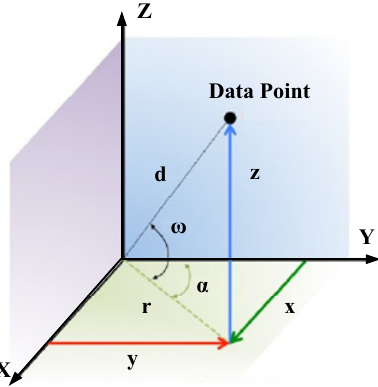
Figure 2. The conversion relationship of the data point from spherical coordinates to XYZ coordinates.